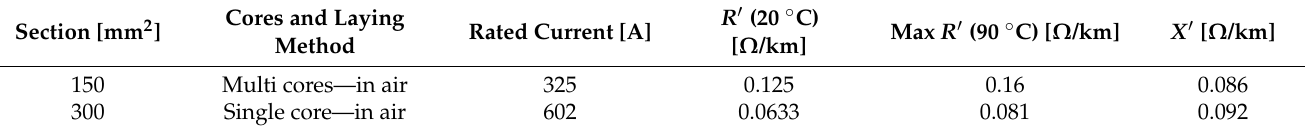
Table 11. Electrical data and technical characteristics assumed for 6-kV